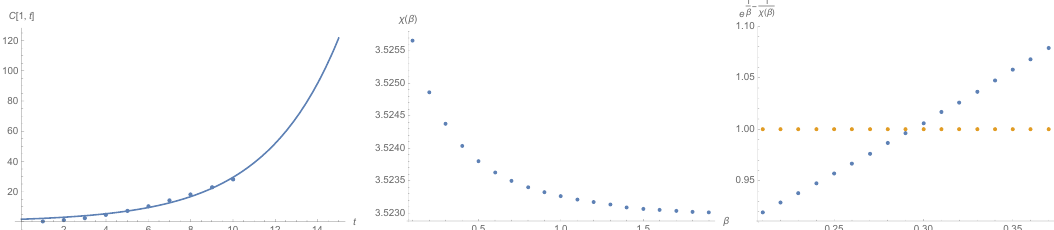
Figure 5. Time evolution of the correlation function C ( β , t ) (84) at temperature β = 1. For the short time intervals the function C ( β , t ) exponentially increases with time. This behaviour is reminiscent to the exponential divergence of the classical trajectories in hyperbolic dynamical systems. As one can see, the exponent χ ( β ) which defines the behaviour of the correlation function of the operators separated in time in the commutator (84), (85) slowly decreases with β . The temperature dependence of 1/ χ ( β ) relative to the maximum growth 1/ β is shown by blue dots at the far right